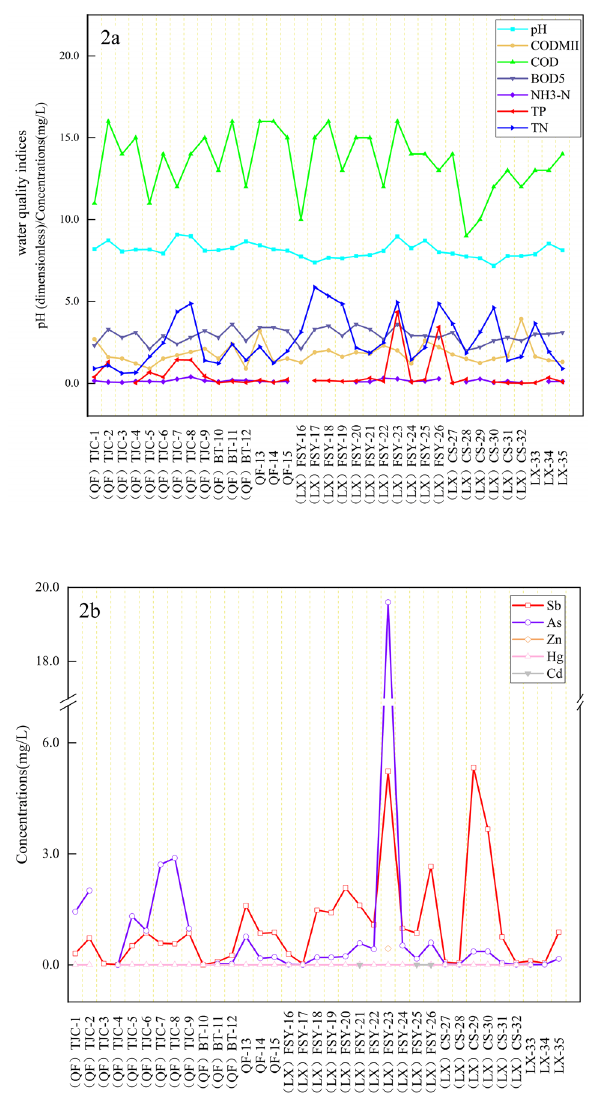
Figure 2. Distribution of water quality indices and heavy metal concentrations at the different sampling points in